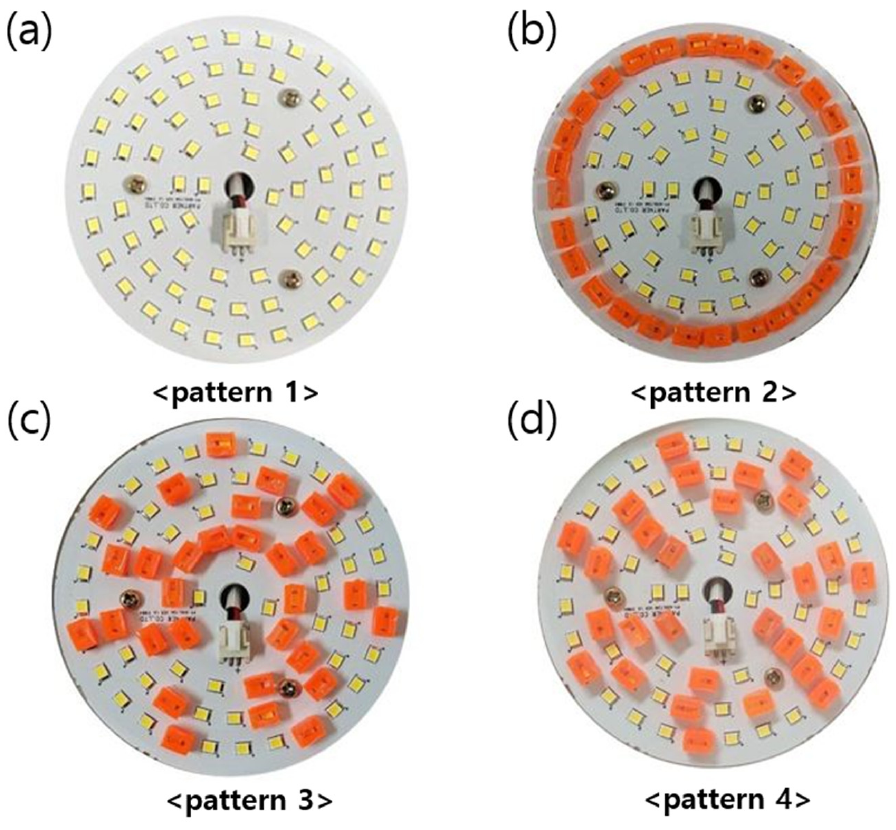
Figure 4. The photos of ( a ) the white LEDs arranged on the PCB and ( b – d ) three different arrange- ments of the red QD caps placed over the white LEDs.